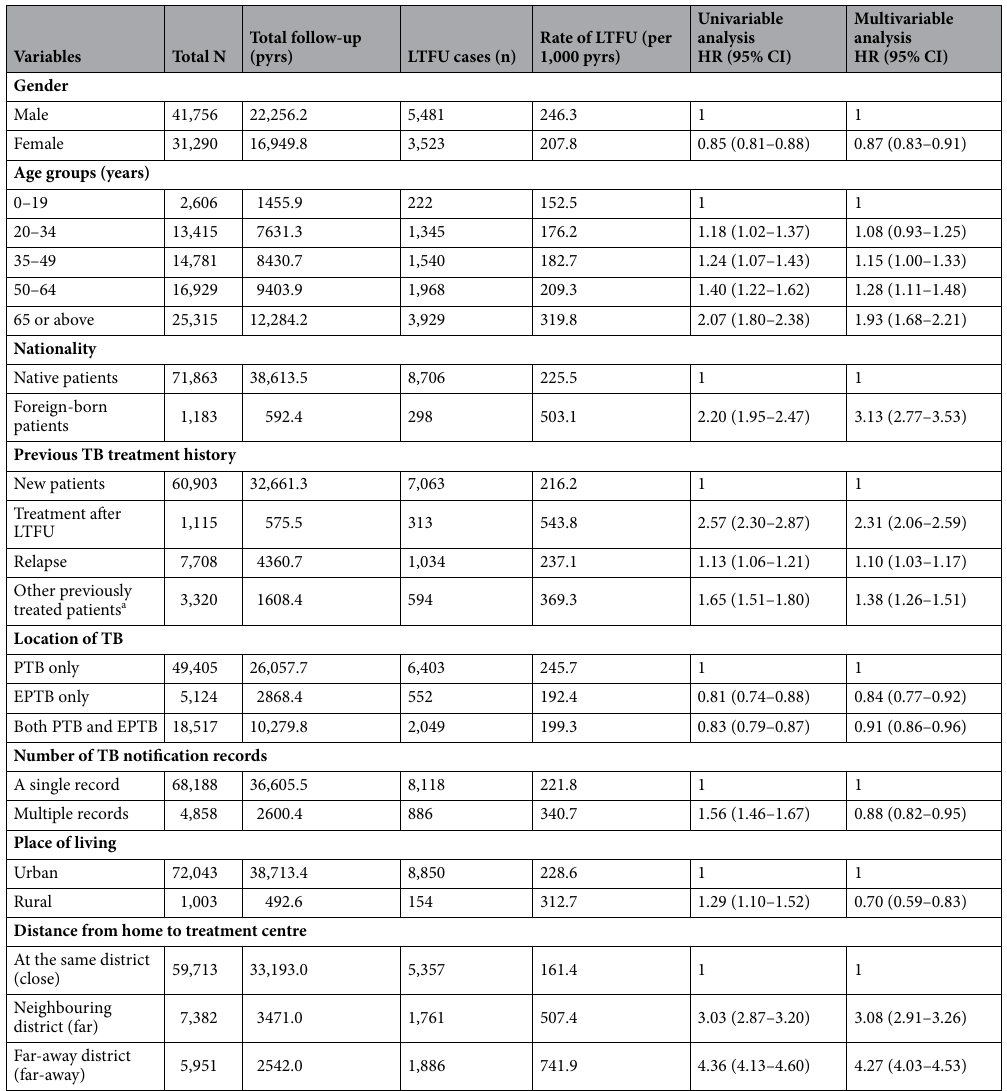
Table 4. Analysis of risk factors for loss to follow-up (versus all other outcomes) among all tuberculosis patients. a Composed of ‘treatment after failure patients’ and ‘other previously treated patients’ whose outcome of previous treatment was unknown or undocumented. HR hazard ratio, CI confidence interval, LTFU loss to follow-up, TB tuberculosis, PTB pulmonary tuberculosis, EPTB extra-pulmonary